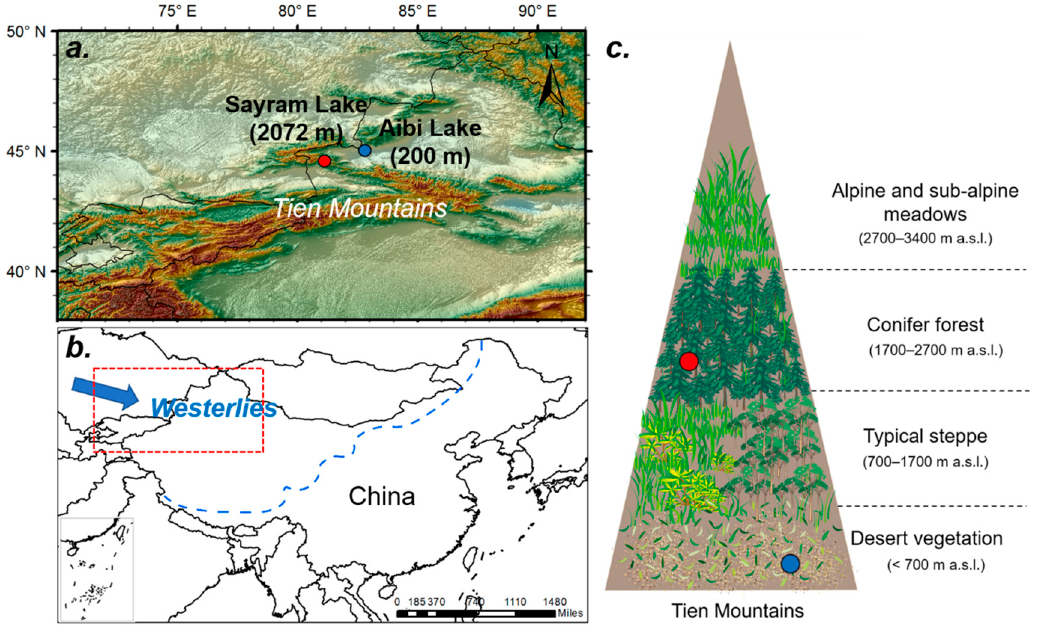
Figure 1. The location of the Tien Mountains in the hinterland of Eurasia, influenced by westerly winds. ( a ) Digital elevation model image of the study area. The red solid dot represents the location of Sayram Lake, while the blue one represents the location of Aibi Lake. ( b ) The red dotted area represents the range of subgraph . The blue dotted line represents the modern limit of the East Asian summer monsoon, which also illustrates the horizontal limit of the westerlies effect. ( c ) Vegetation belts on the northern slope of the Tien Mountains.